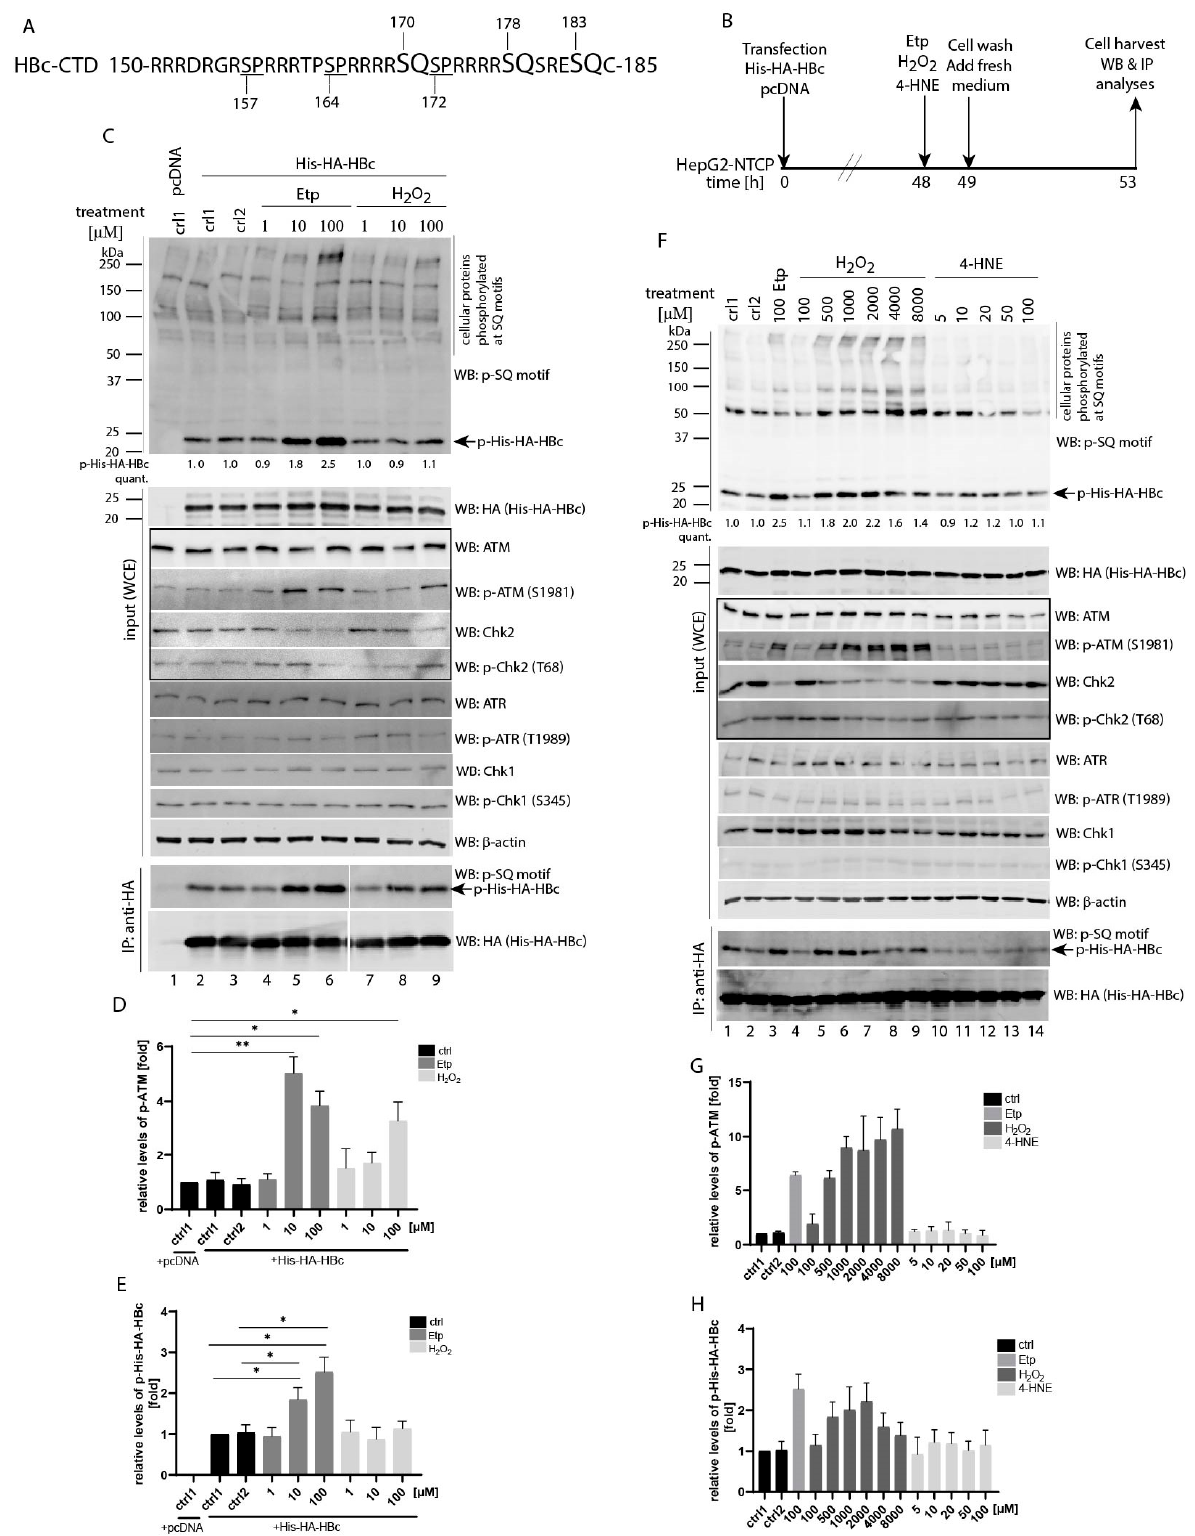
Figure 1. Identification of etoposide- and H 2 O 2 -induced HBc phosphorylation. ( A ) Schematic representation of SP (under- lined, S157, S164 and S172) and SQ (larger font, S170, S178 and S183) motifs in the C-terminal domain of the HBc protein. The sequence of wild type (wt) HBc corresponds to a 185-aa HBc of HBV genotype A, subtype adw2. ( B ) The experimental outline: HepG2-NTCP cells were transfected with equal amounts of His-HA-HBc wt or an empty vector (pcDNA). Forty- eight hours after transfection, the cells were treated with etoposide, hydrogen peroxide (H 2 O 2 ) or 4-hydroxynonenal (4-